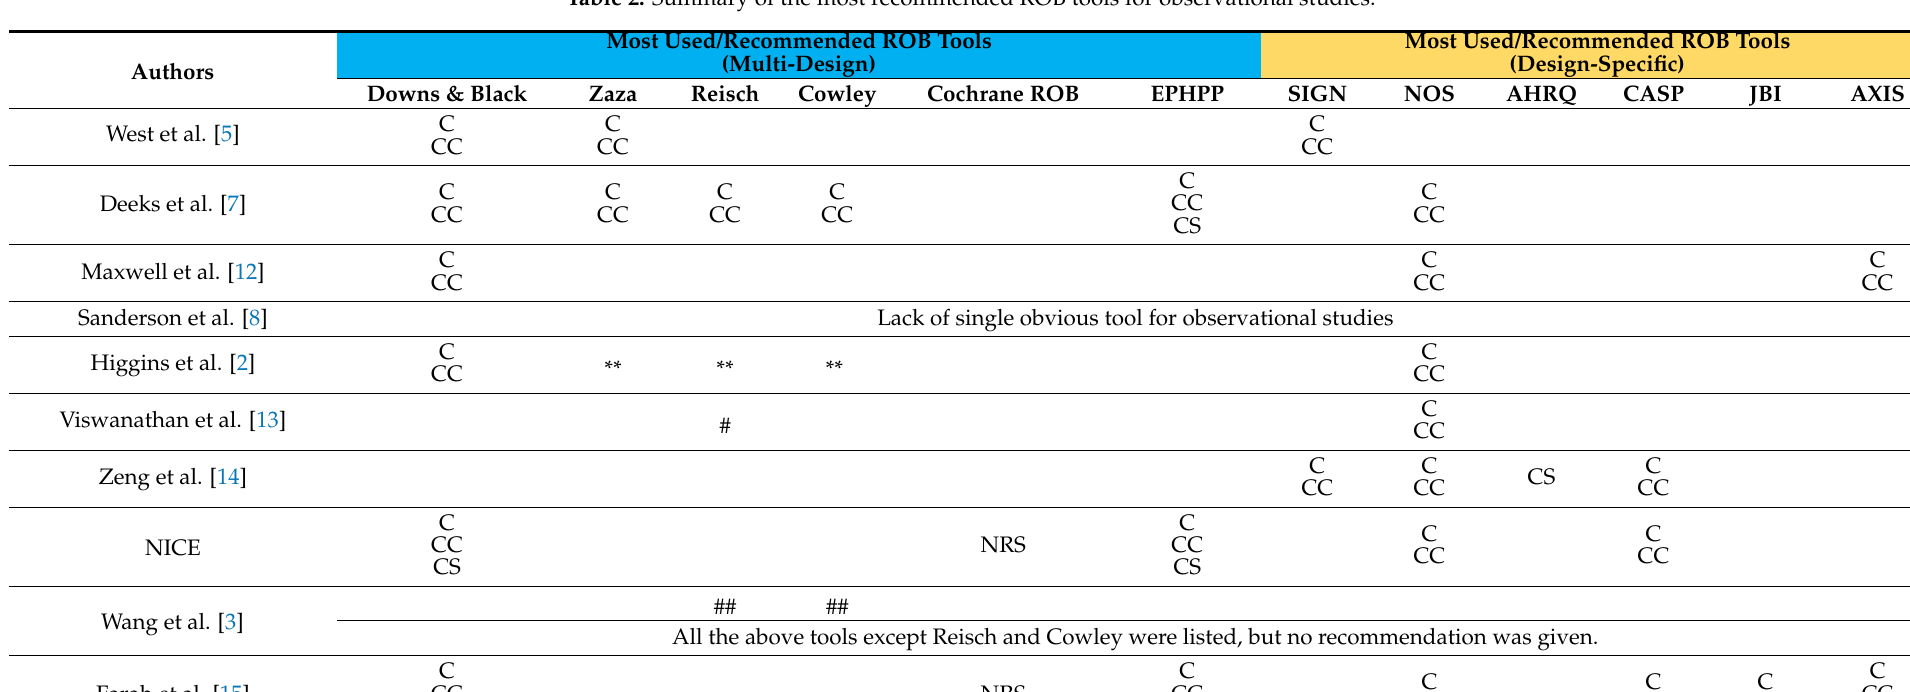
Table 2. Summary of the most recommended ROB tools for observational